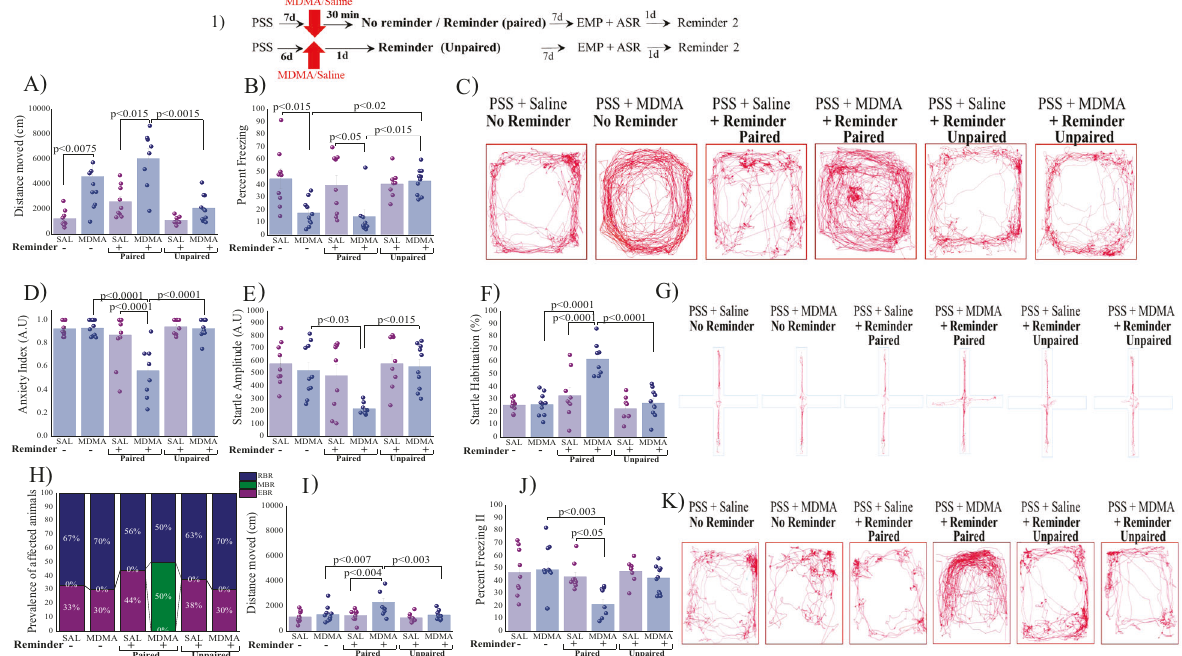
Fig. 3 MDMA treatment timely paired with trauma-cue attenuates behavioral stress responses (1) Top panel: experimental protocol. Vertical arrows represent intraperitoneal MDMA (5 mg/kg) or saline injection. Rats were exposed for 10 min to predator-scent stress (PSS) on day 0. On day 7, rats received MDMA or saline and 30 min later were exposed for 10 min to a reminder (PSS + saline + Reminder: n = 9; PSS + MDMA + reminder (Paired): n = 8) or not (without reminder) (PSS + saline alone: n = 9; PSS + MDMA alone: n = 10). In addition, 2 groups of rats were exposed to PSS and six days thereafter, MDMA or saline were administered, one day before exposure to the situational reminder (PSS + saline + Reminder: n = 8; PSS + MDMA + Reminder (unpaired): n = 10). During this time A LMA (distance moved; measured in cm); B Percent freezing response [Two-way ANOVA: Treatment effect: ( F (1,32) = 16.75, p < 0.0003)]; C Representative patterns of locomotor activity (cumulated values) in all groups. Behavioral measurements (EPM and ASR) were performed on day 14 and freezing behavior on day